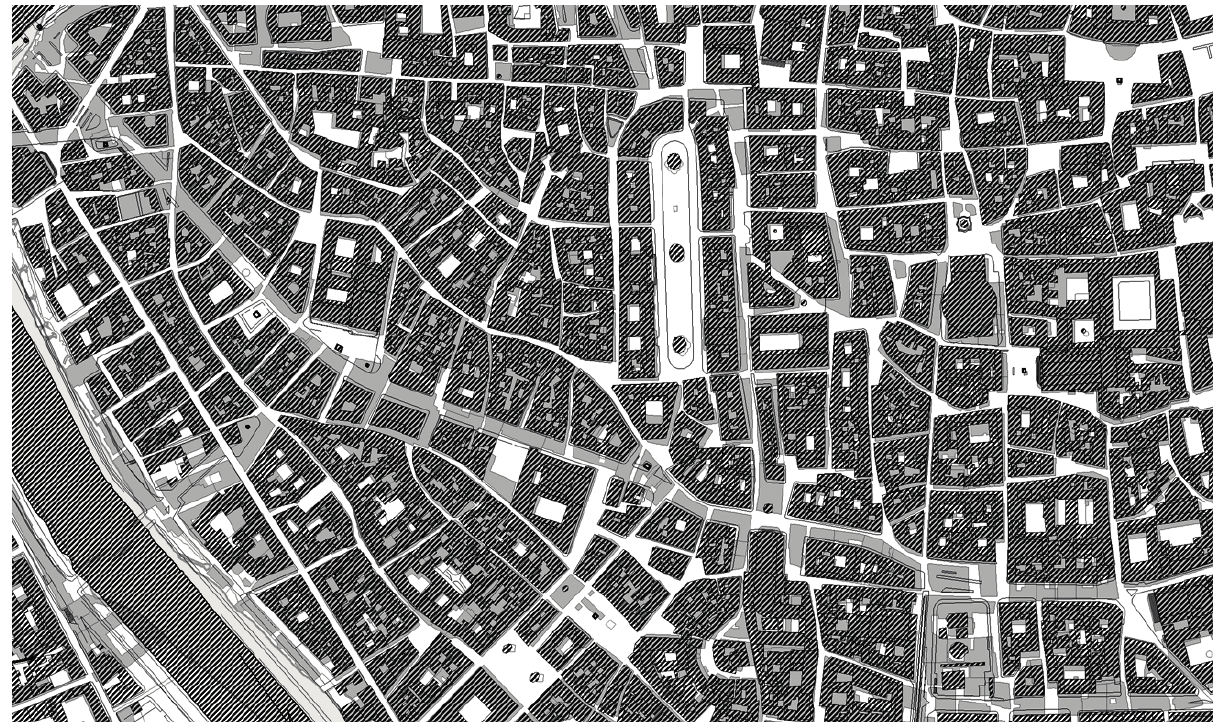
Figure 5. Confrontation between the Nuova pianta (black hatching, vectorial format) and actual